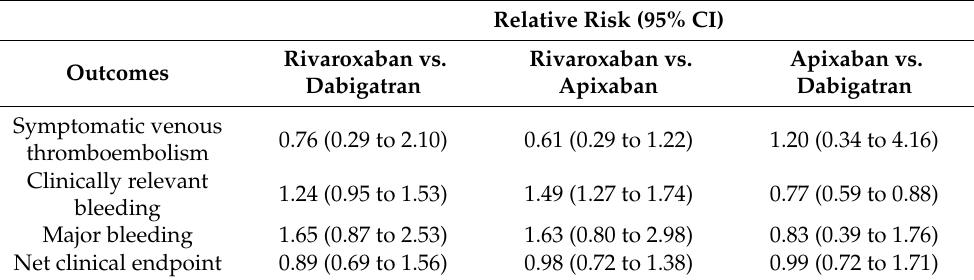
Table 2. Indirect comparisons between apixaban, rivaroxaban, and dabigatran *.